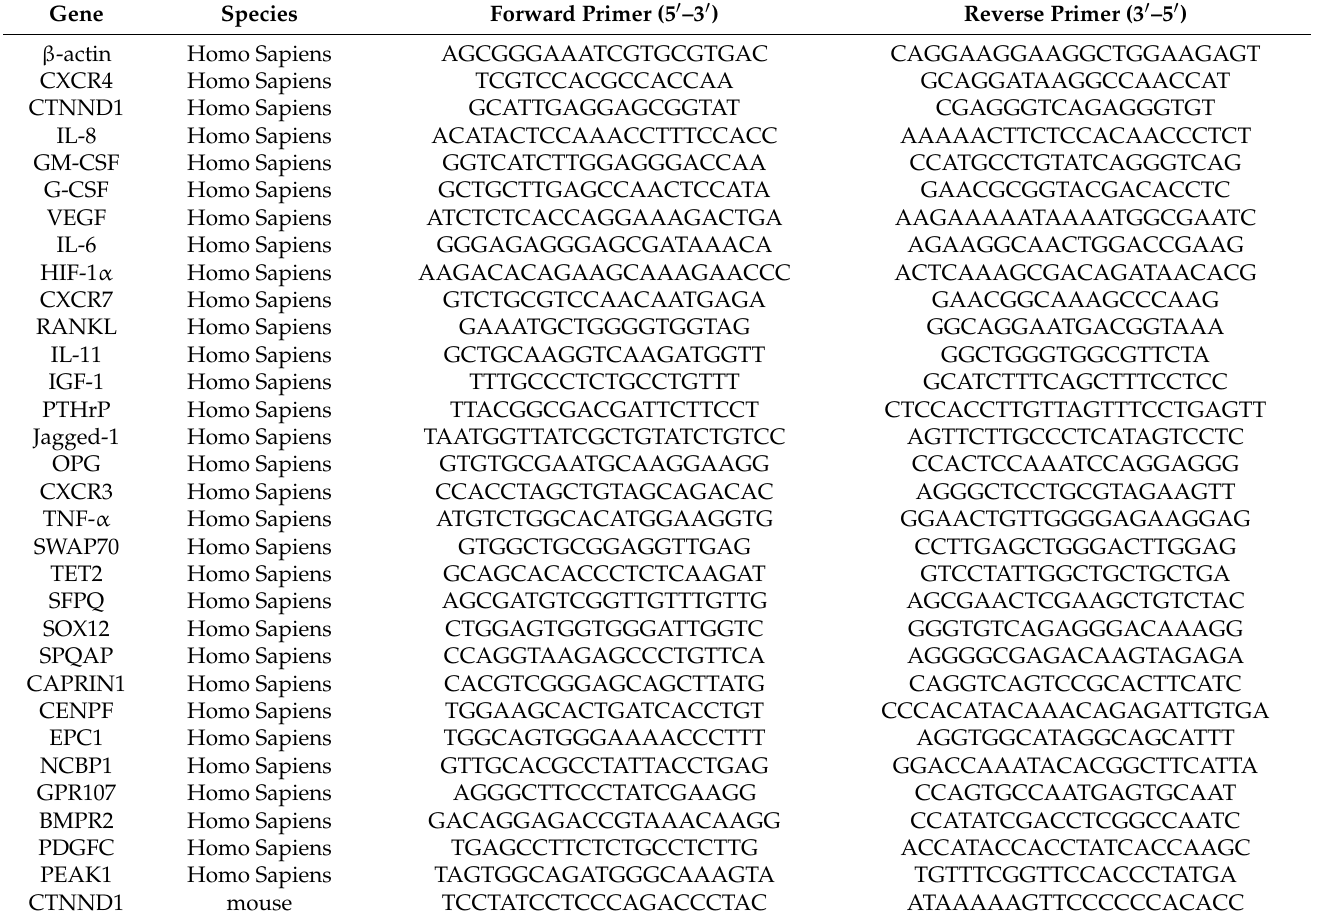
Table A1. Nucleotide sequence of the primers used for